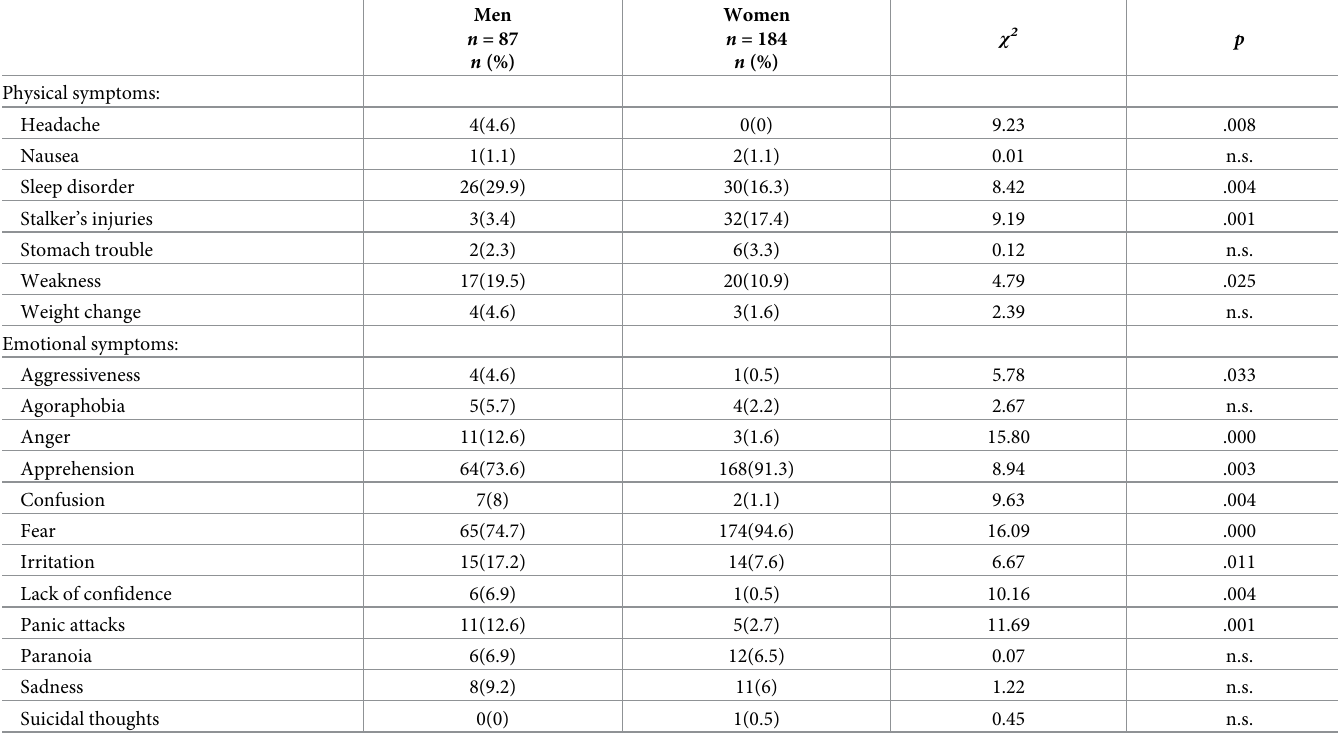
Table 3. Physical and Emotional symptoms in men and women reporting stalking case (N =